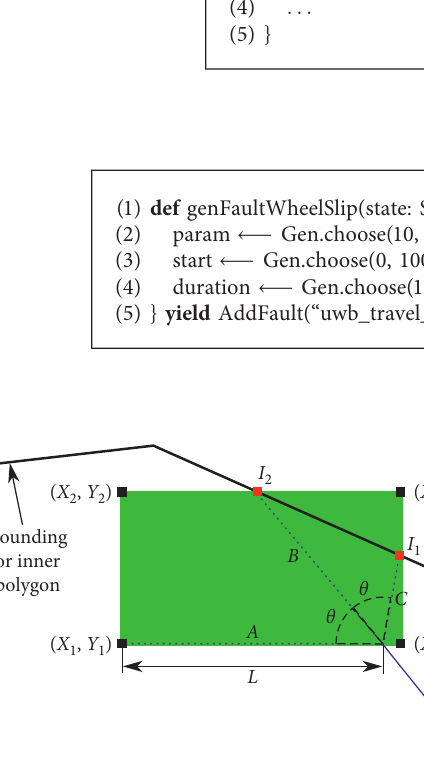
Figure 7: Rectangle considered for trajectory segment